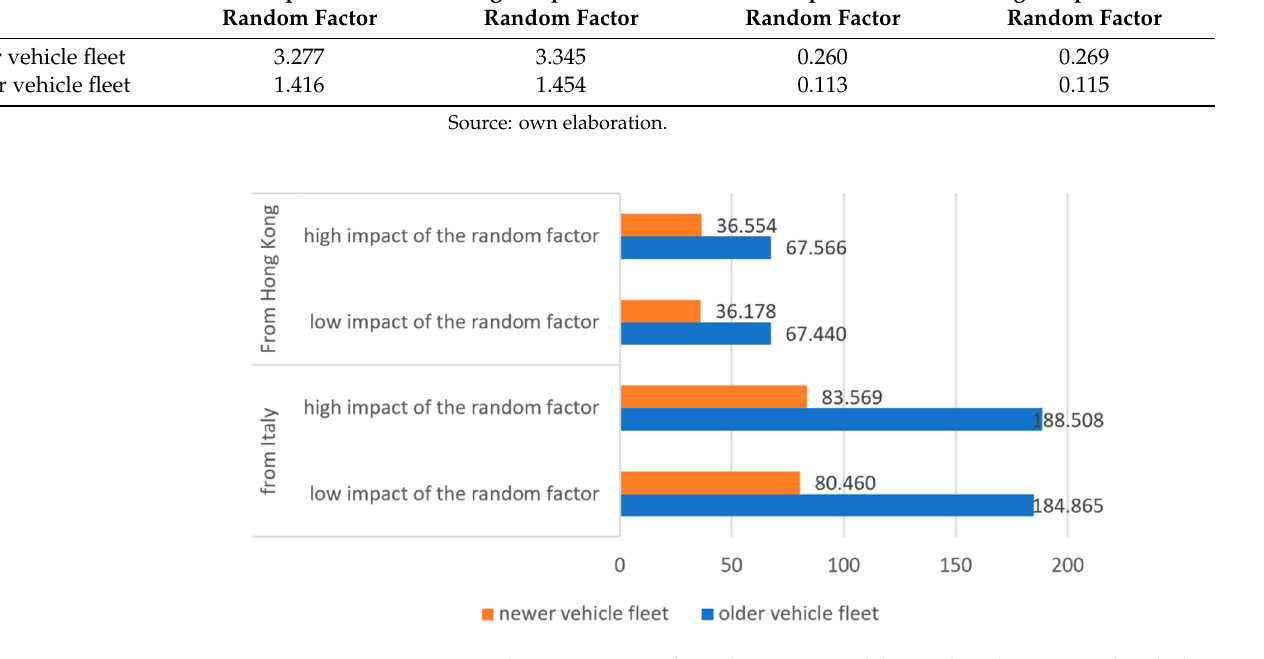
Figure 6. CO 2 emission values per tonne of goods transported for analysed scenarios for clothes suppliers. Source: own elaboration.